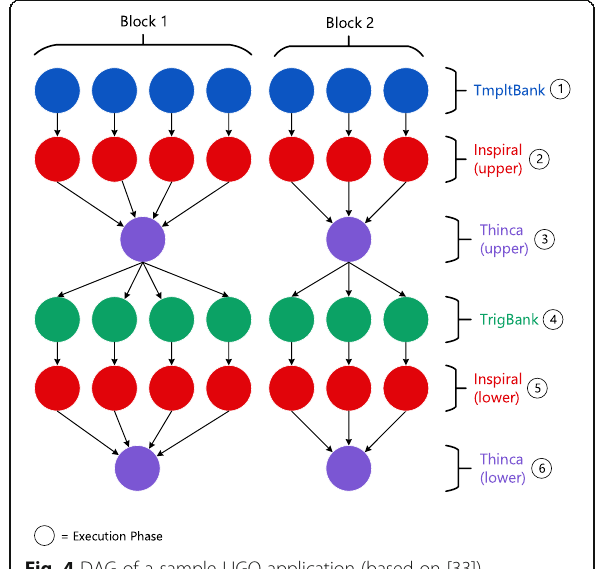
Fig. 4 DAG of a sample LIGO application (based on [33])